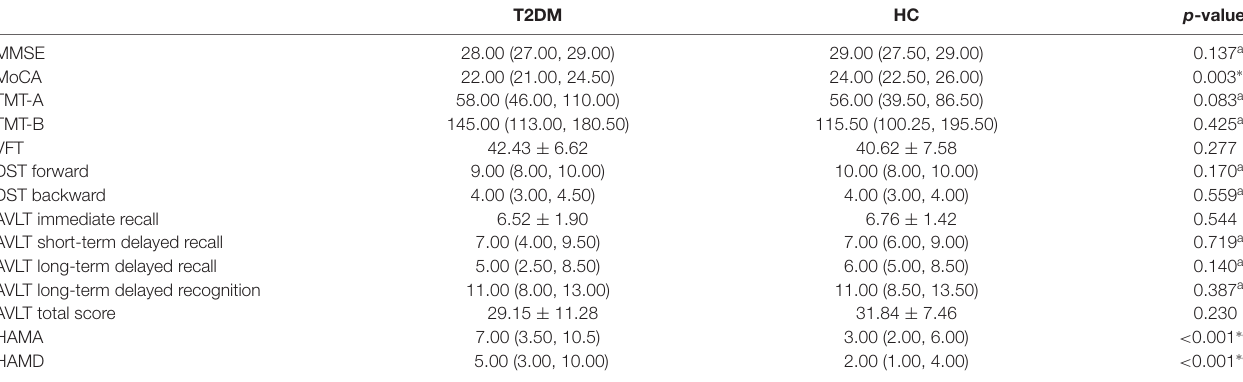
TABLE 2 | Neuropsychological test comparison.